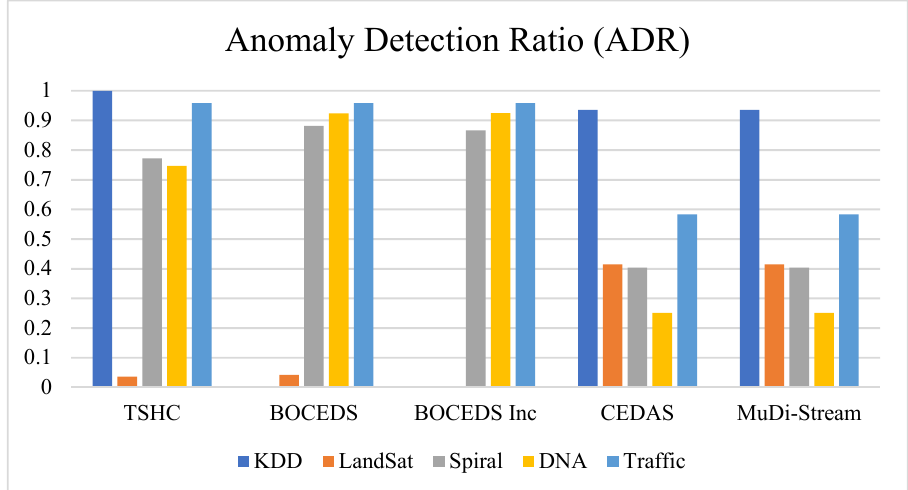
Figure 4. Anomaly Detection Ratio Comparison Using KDDCup’99, Landsat, Spiral, DNA, and Traffic Datasets.